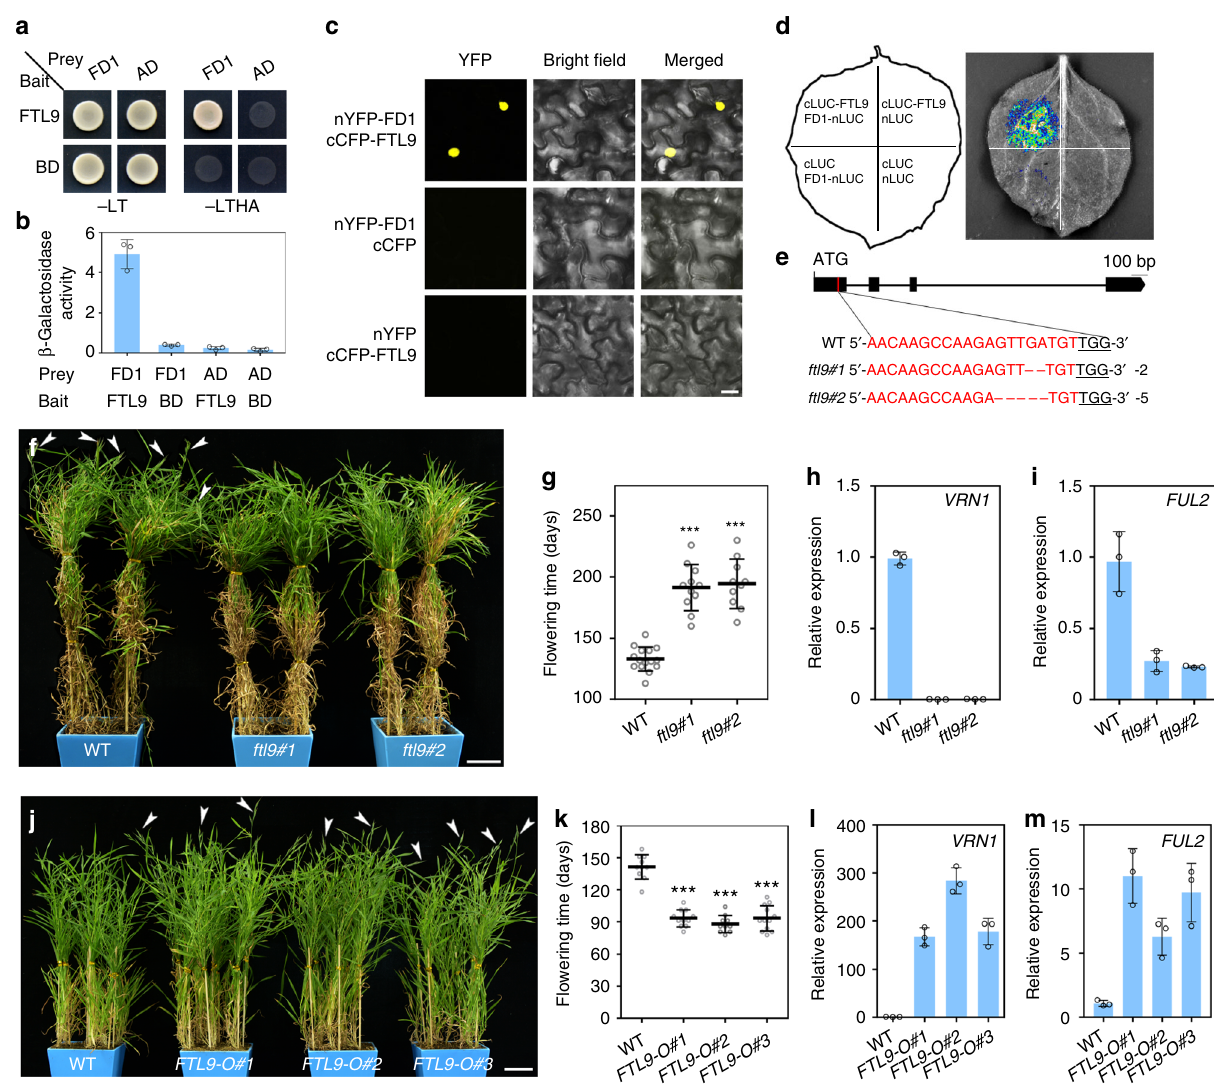
Fig. 2 FTL9 is a promoter of fl owering under SDs in B. distachyon . a Interaction analysis between FTL9 and FD1 in yeast cells. Yeast cells growing on selective media without Leu, Trp, His and Ade (-LTHA) represent positive interactions. b Relative quanti fi cation of FTL9 and FD1 interactions by β -Gal activity in yeast two-hybrid assays. Bars indicate s.d. c BiFC assays for determination of FTL9 and FD1 interactions in N. benthamiana leaf cells. Scale bar, 20 μ m. d Fire fl y luciferase complementation imaging (FLCI) assays of FTL9 and FD1 interactions in N. benthamiana leaves. e CRISPR/Cas9-mediated target mutagenesis of FTL9 . Top: a schematic diagram of the FTL9 bearing the CRISPR-Cas9 target sites. Exons and introns are represented by black boxes and lines, respectively. The lower sequences show the alignment of wild-type Bd21, ftl9-1 and ftl9-2 sequences containing the CRISPR-Cas9 target sites. The ftl9-1 and ftl9-2 mutants contain a 2-bp and 5-bp deletion, respectively. The black underlined sequences mean protospacer adjacent motifs. f Representative phenotypes of two ftl9 mutants under SDs. White arrows point to spikes. Scale bar, 5 cm. g Flowering time of wild-type (WT) Bd21 and the ftl9 mutants under SDs. At least 10 plants for each line were scored. (Student ’ s t test, *** P < 0.001). h qPCR analysis of fl owering downstream gene VRN1 expression in eight-week-old wild-type and the indicated ftl9 mutants under SDs. Error bars indicate s.d. i qPCR analysis of fl owering downstream gene FUL2 expression in eight-week-old wild-type and two ftl9 mutants under SDs. Error bars indicate s.d. j Representative phenotypes of three FTL9 over- expressing plants under SDs. White arrows point to spikes. Scale bar, 5 cm. k Flowering time of wild-type Bd21 and the FTL9-OE plants under SDs. At least 10 plants for each line were scored. (Student ’ s t test, *** P < 0.001). l qPCR analysis of fl owering downstream gene VRN1 expression in eight-week-old wild- type and the FTL9-OE plants under SDs. Error bars indicate s.d. m qPCR analysis of fl owering downstream gene FUL2 expression in eight-week-old wild- type and the FTL9-OE plants under SDs. Error bars indicate